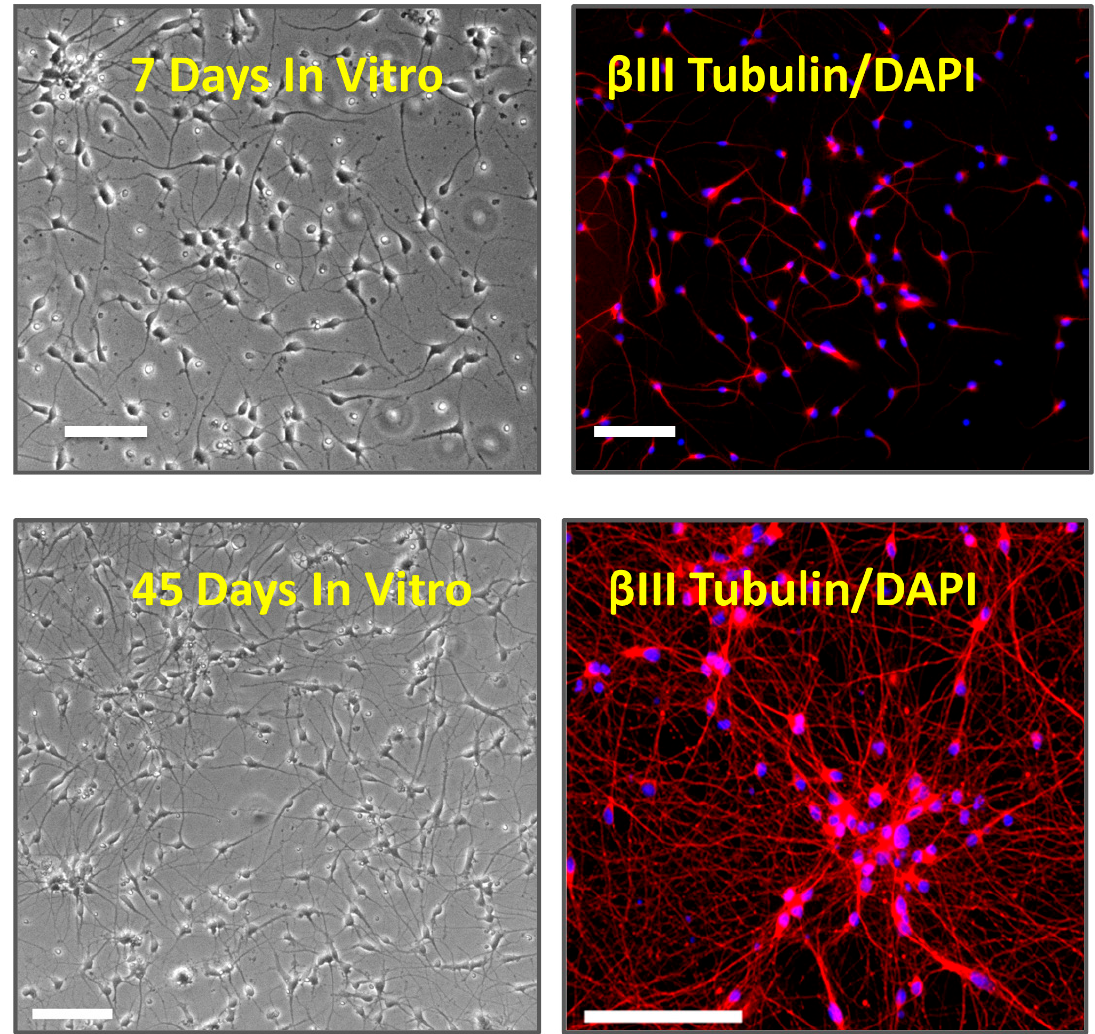
Figure 1. Phase-contrast image ( × 200) of iCell neurons (top left) and labeled for β III Tubulin (red) + DAPI (blue, top right) at 7 and 45 days in vitro . Note the increased density of neurites and formation of cell clumping at 45 days. The phase-contrast and immunolabeled images are from different coverslips of the same iCell cultures. The calibration bars are 100 μ m.